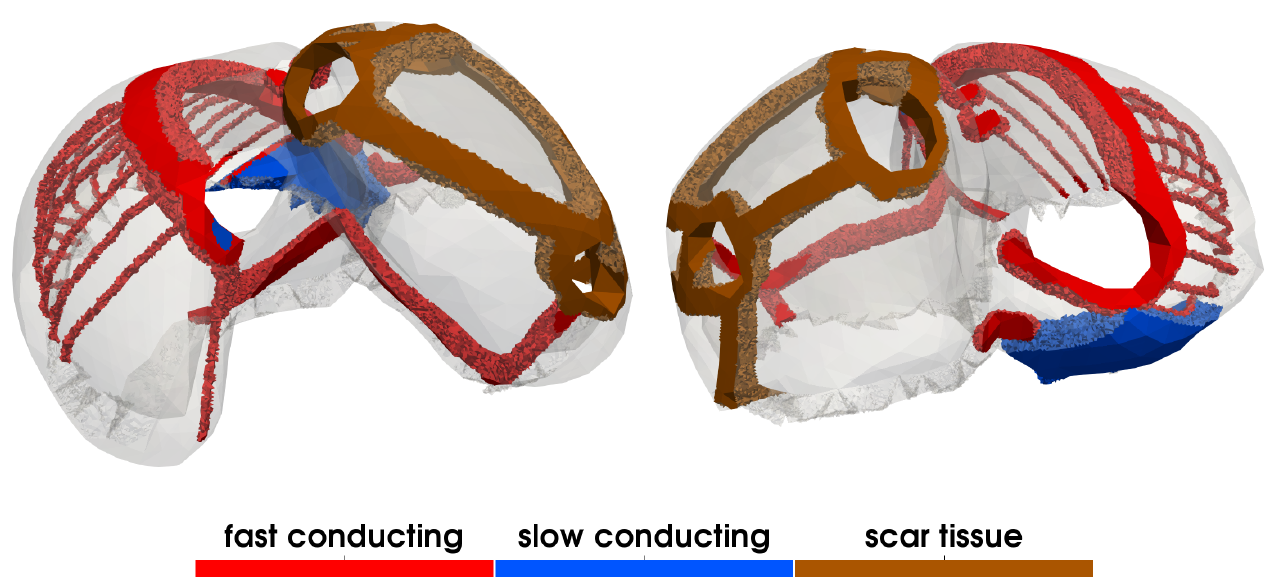
Figure 5. Anterior (left) and posterior (right) view of the atria with labels for fast conducting and slow conducting materials, as well as the scar. Transparant volumes represent the atrial bulk